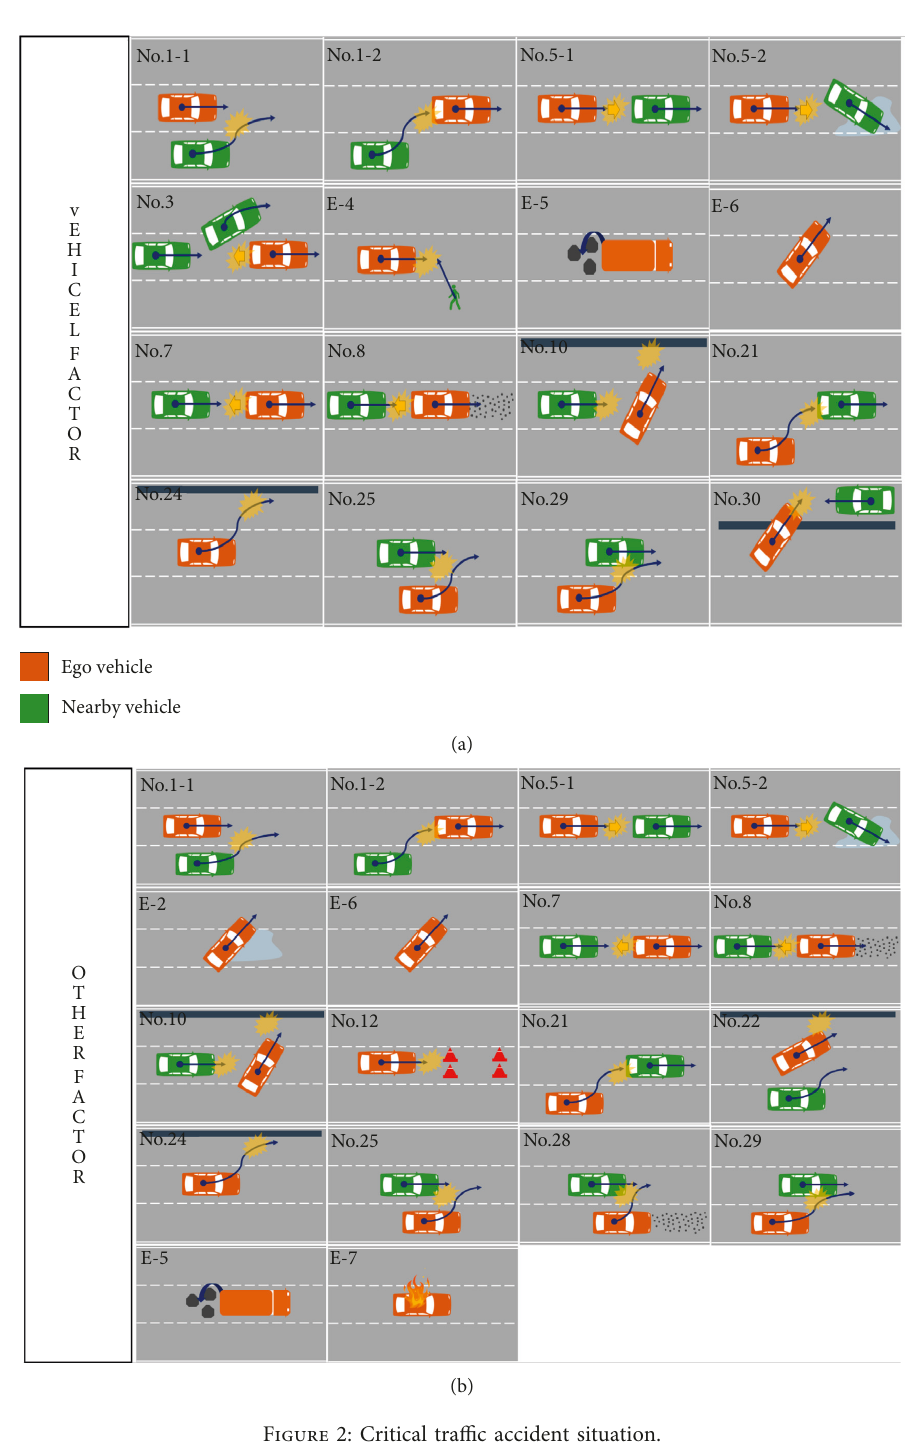
Figure 2: Critical traffic accident